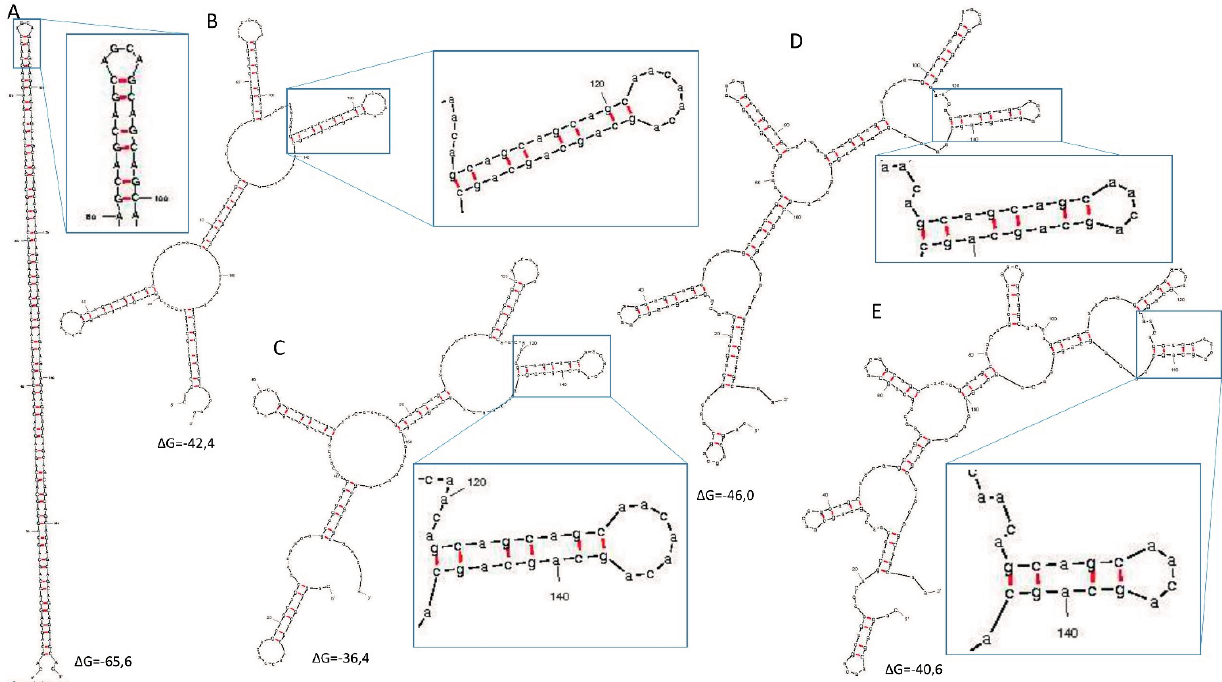
Figure 2. RNA structures of different repeat tracts containing 60 repeats predicted using Mfold [32–34]. Predictions were made using default settings, and structures having the lowest free energy of formation are presented. ( A ) Hairpin structure predicted for the pure CAG repeat tract; ( B ) the (CAG) 4 (CAA) 2 repeat tract; ( C ) the (CAG) 3 (CAA) 2 tract; ( D ) the (CAG) 3 CAA tract; and ( E ) the (CAG) 2 CAA